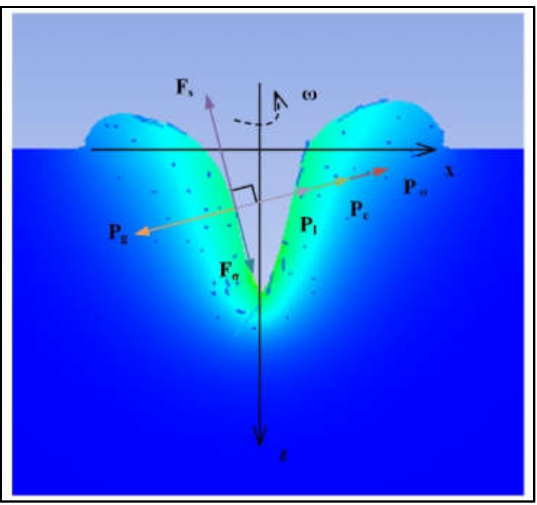
Figure 7. Force analysis of keyhole